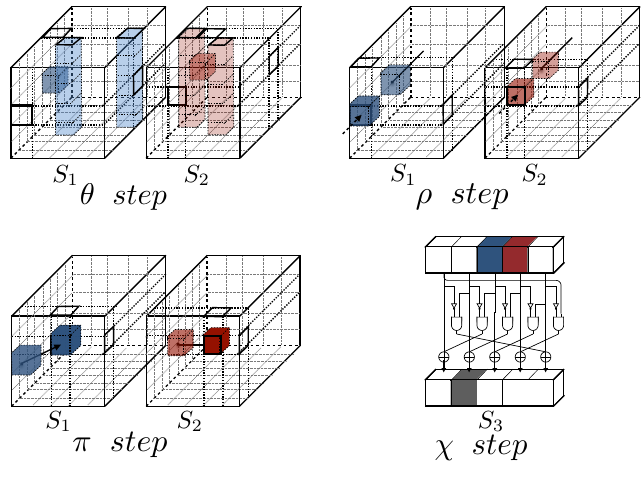
Figure 10: Tracing back output bit C χ [4 , 1 ,